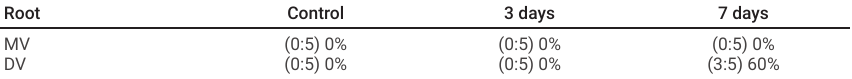
Table 2. Frequency of root resorption (animals by total in group), according to the OTM period and root analyzed. Root